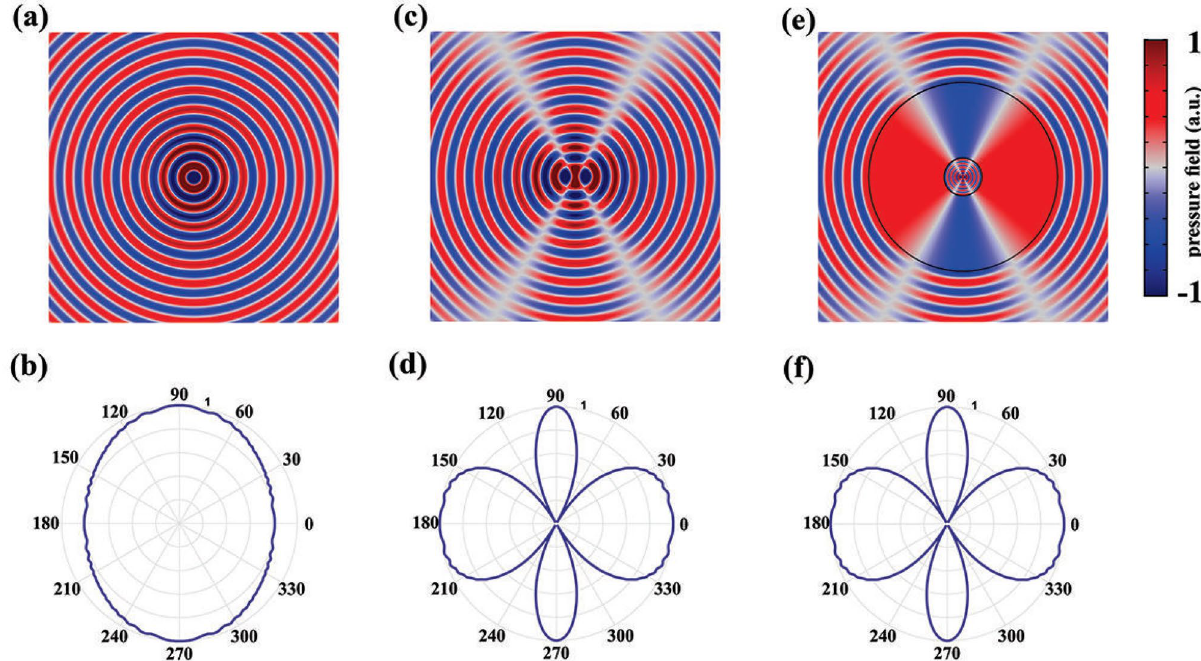
Figure 2. ( a , b ) The near and far field results of two line sources located at the sub-wavelength distance of d 0.2 (cid:31) . It is clear that the diffraction effect is significant in this case, which subsequently leads the farfield = image to not be resolved appropriately. ( c , d ) The results of the same sources when they are separated by the (cid:31) which is not sub-wavelength. It is evident that under this circumstance, the generated image distance of D = in the farfield can be resolved which is attributed to the fact that the diffraction limit has been obviated. ( e , f ) The near and far field results of the designed ASML with ANM when the sources are located at the sub-wavelength 0.2 (cid:31) ). The obtained results are well abiding the attained results in ( c , d distance (i.e., d =